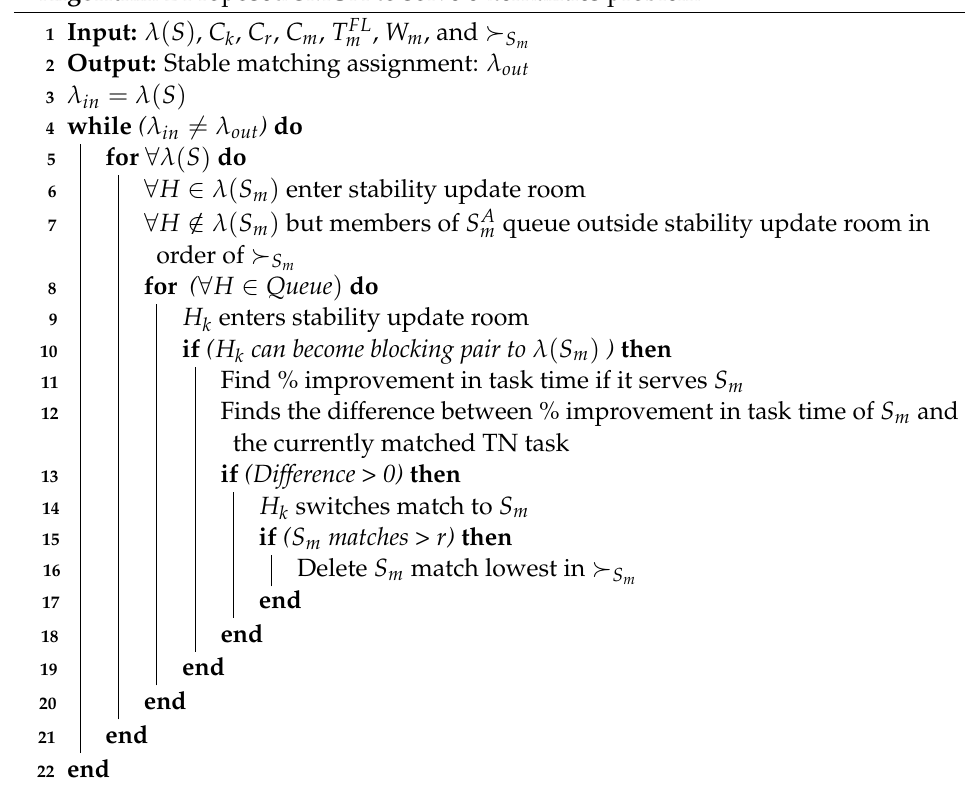
Algorithm 2 Proposed SMUA to solve externalities